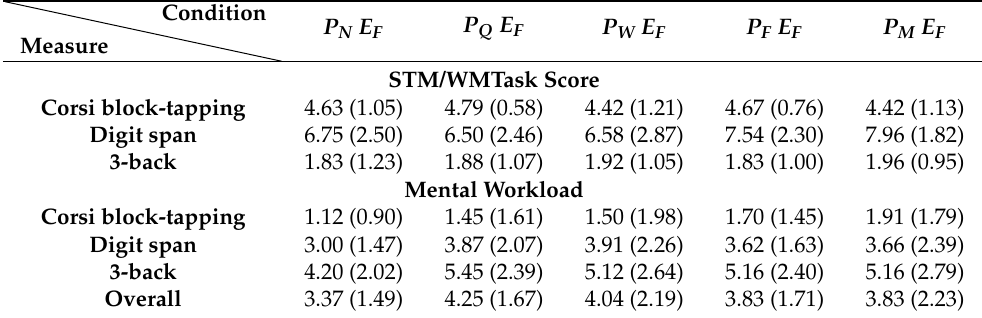
Table 2. The mean and standard deviation values of all dependent variables for each experimental condition in Experiment 2.